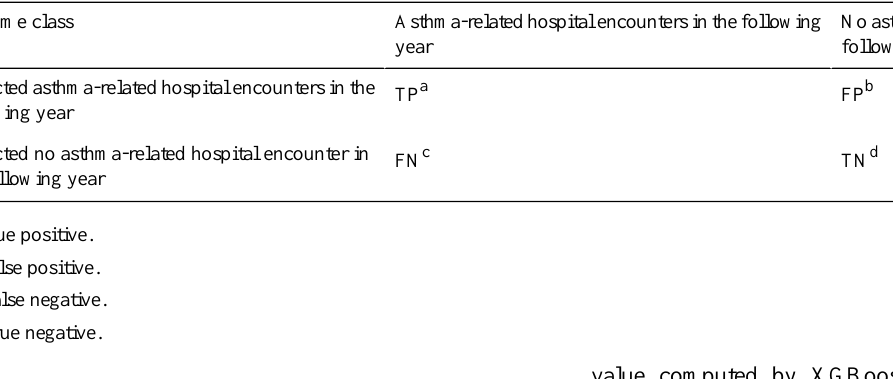
Table 1. The error